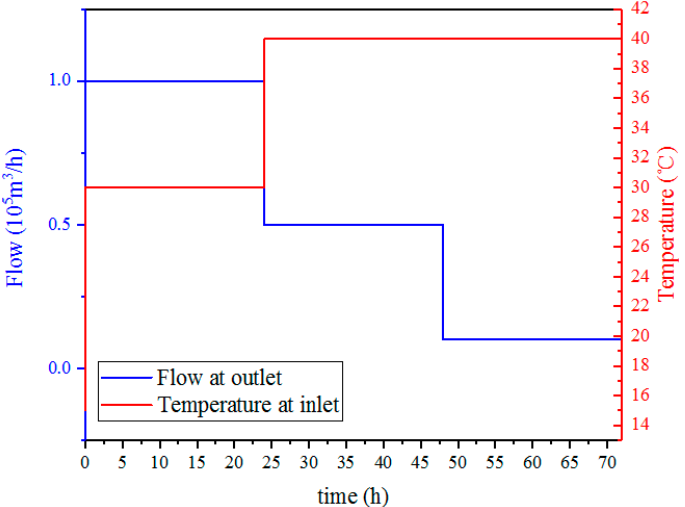
Figure 2. Boundary conditions.